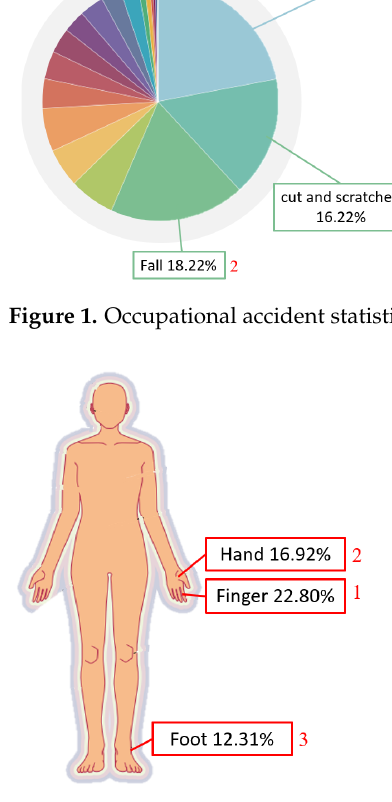
Figure 2. Bodily injury sites, from occupational accident statistics of the Labor Insurance Bureau of Taiwan in 2020 [5].